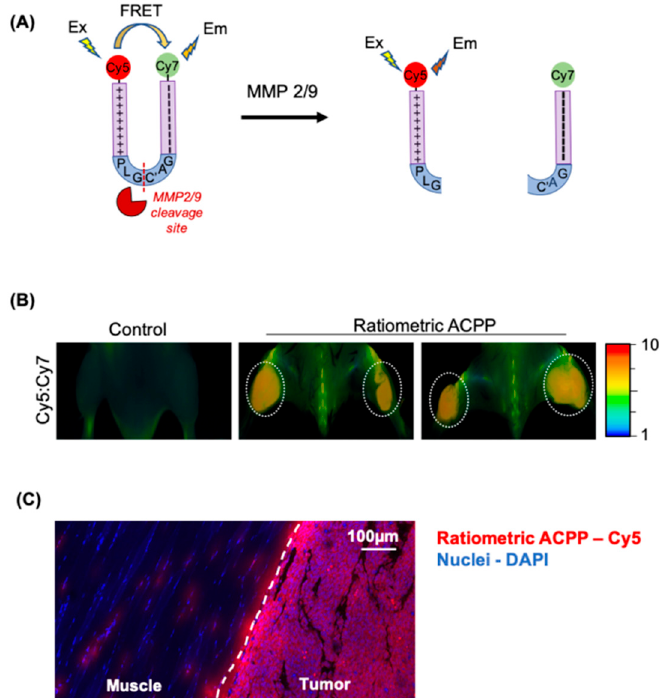
Figure 3. ACPPs are cleaved in situ within murine tumors. ( A ) Structural representation of rati-